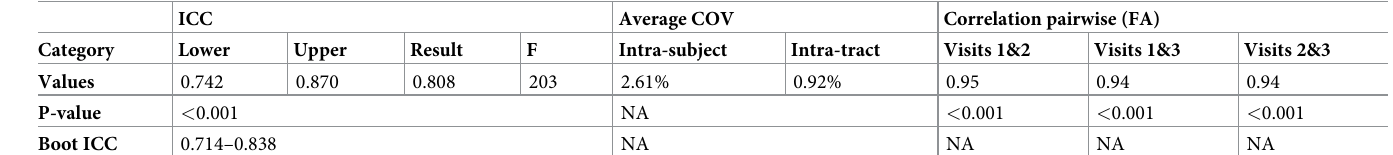
Table 2. Test-retest results.